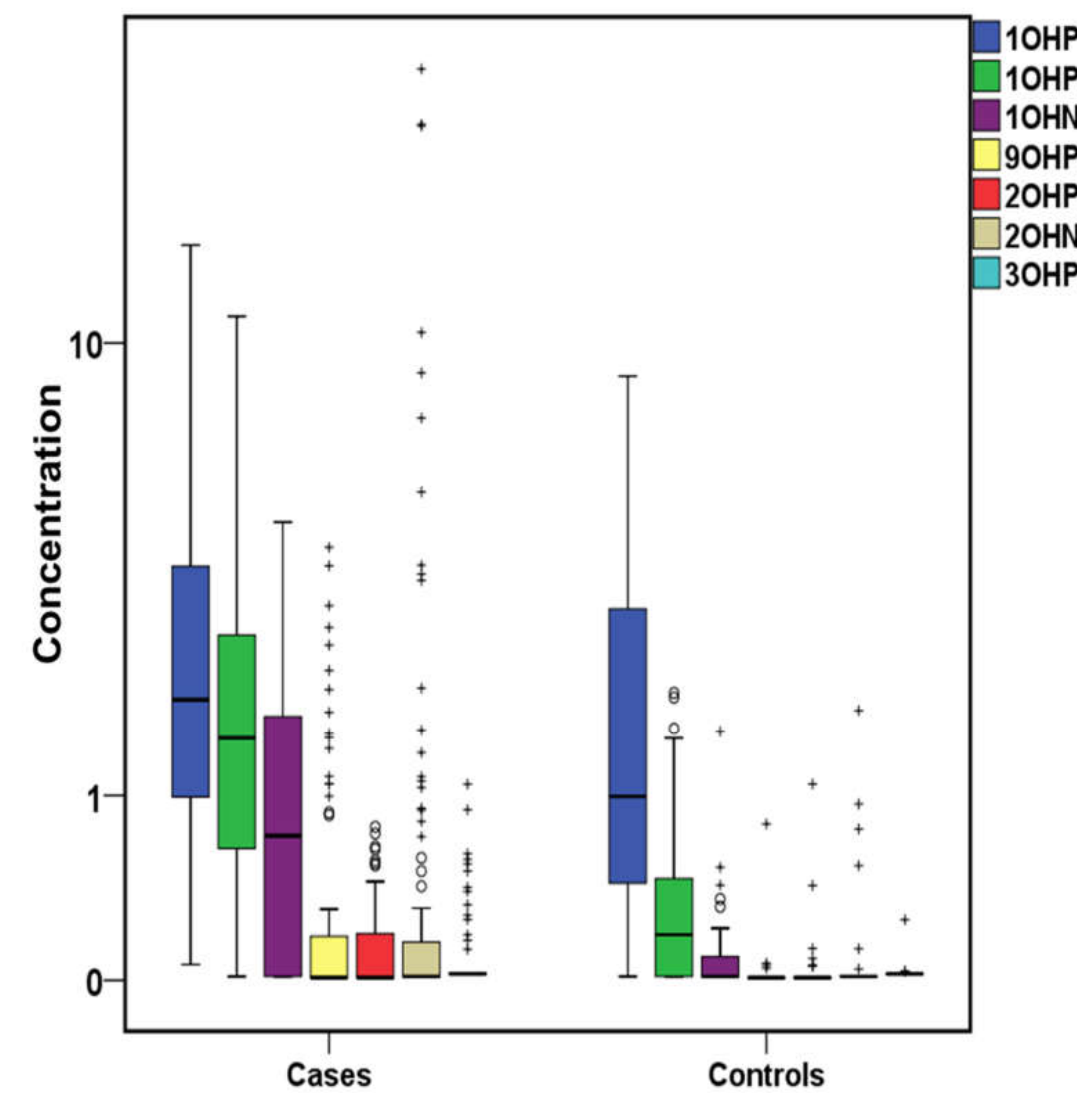
Figure 2. Variation of OHPAHs (μg L −1 ) both for cases and controls ( + outliers, o values above 3rd quartile and * p -value < 0.05) in logarithmic scale (1OHPYR:1-hydroxypyrene, 1OHPHE:1-hydroxyphenanthrene, 1OHNAP:1-naphthol, 9OHPHE:9-hydroxyphenanthrene, 2OHPHE:2-hydroxyphenanthrene, 2OHNAP:2-naphthol, 3OHPHE:3–hydroxyl-phe- nanthrene).